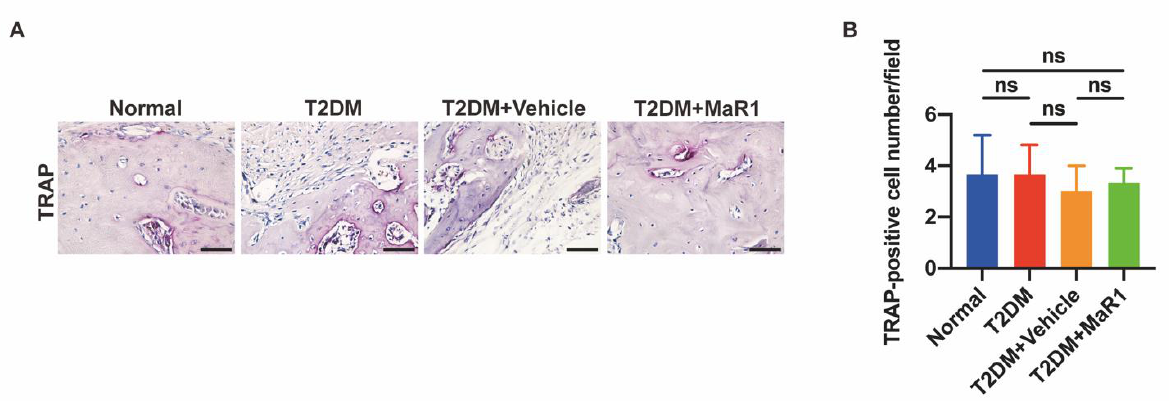
Figure A8. Osteoclasts were detected by TRAP staining. ( A ) In each group, TRAP-positive multin- ucleated cells were sparsely distributed in the marrow cavity of the newly formed bone and at the edge of the old bone at 28 days after surgery. ( B ) By semi-quantitative analysis of the number of TRAP-positive cells, no statistically significant differences were found between the groups. Scale bar = 50 µ m. Data are presented as the means ± SDs from three separate experiments (n = 3). ns p >